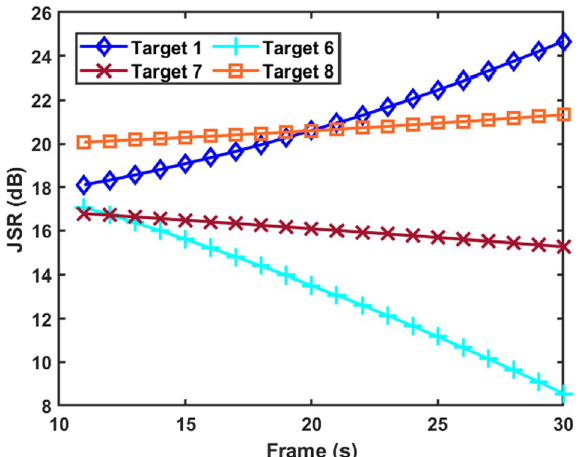
Fig. 6 Time-varying interference intensity model